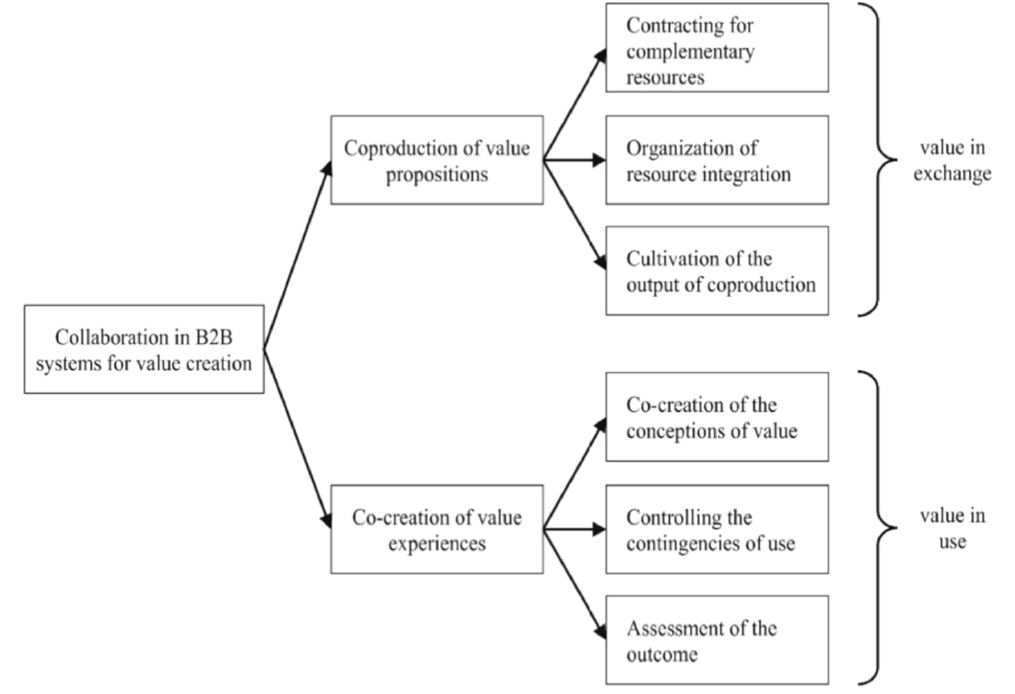
Figure 1. Practices of collaboration in business-to-business (B2B) systems for value creation (Kohtamäki and Rajala 2016, p.10).